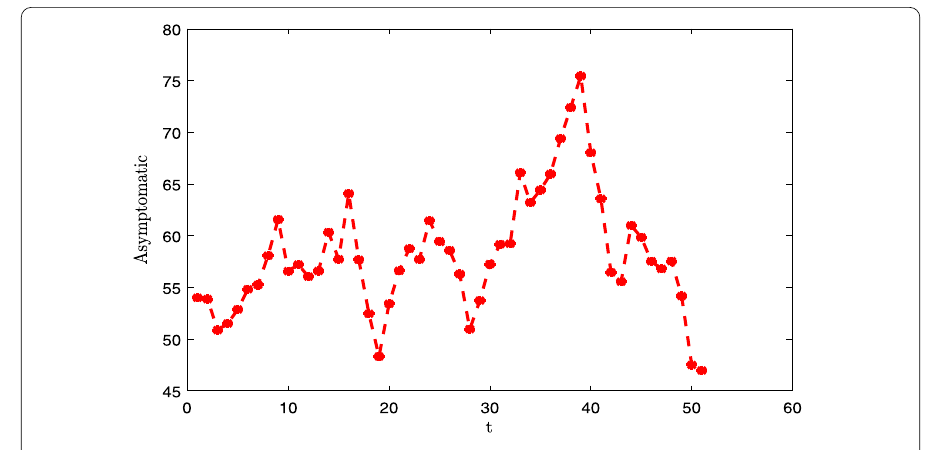
Figure 2 Dynamics of the asymptomatic individuals